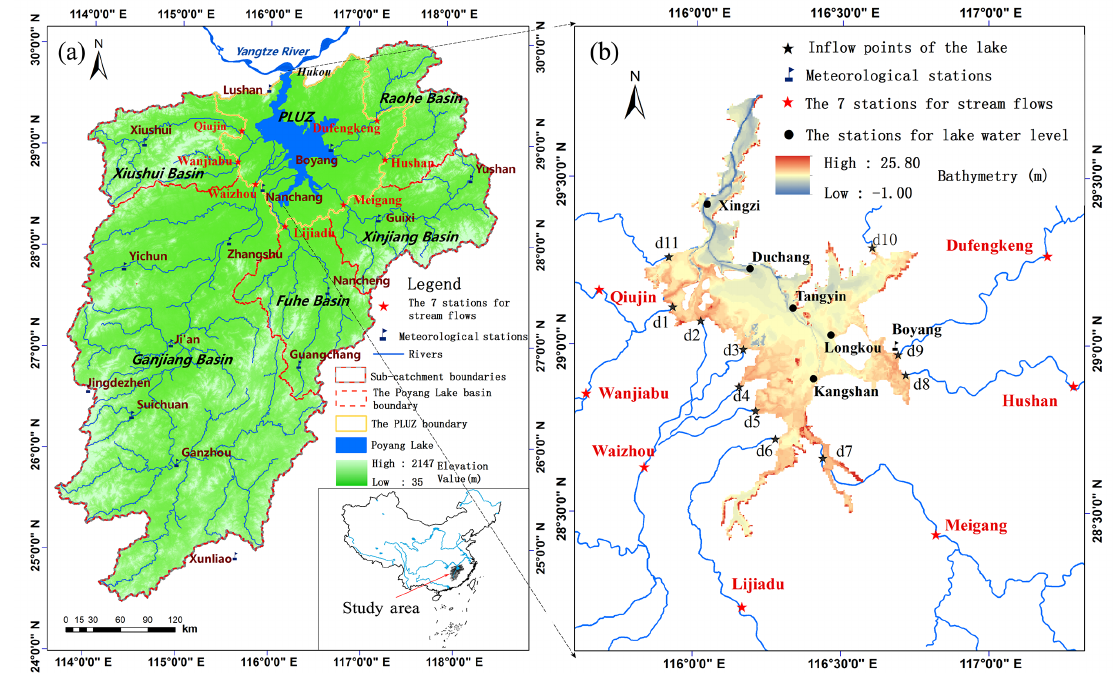
Figure 1. Study area and the related data. (a) The location of the Poyang Lake watershed, Poyang Lake Ungauged Zone (PLUZ), five major river sub-catchments, meteorological stations, and hydrological stations; (b) location of the lake, inflow points, and water level stations.